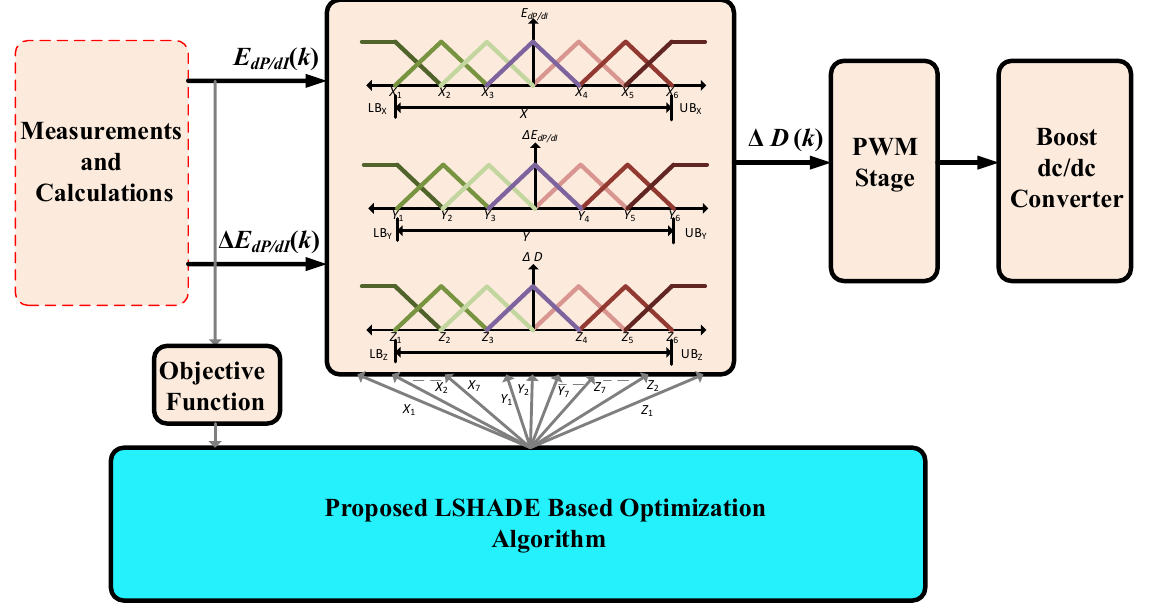
Figure 10. The main structure of the proposed LSHADE-based FLC design optimization